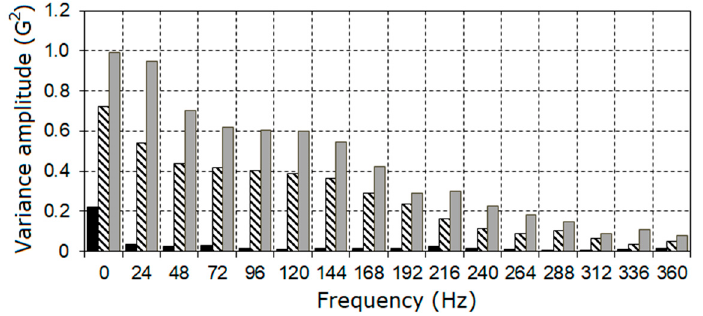
Figure 13. The amplitude spectrum of the variance periodical variation.